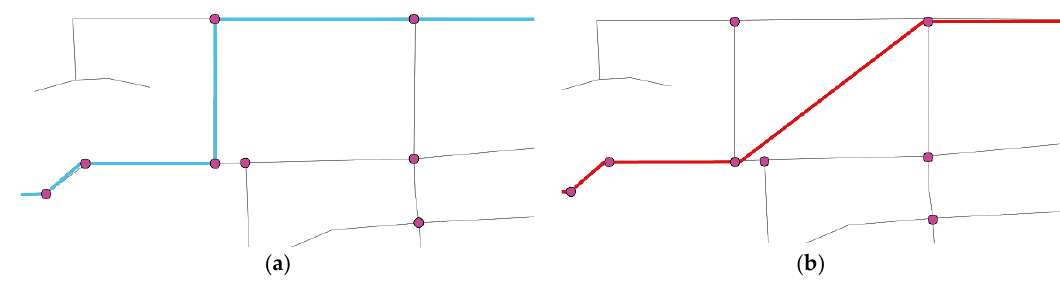
Figure 4. shortest path findings with ( a ) existing segments; ( b ) new shortcut. Figure 4. Shortest path findings with ( a ) existing segments; ( b ) new shortcut.